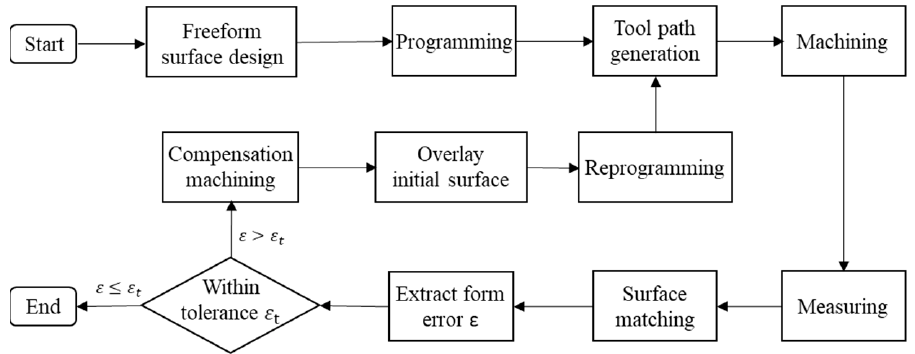
Figure 3. Flowchart of compensation machining. Simulation